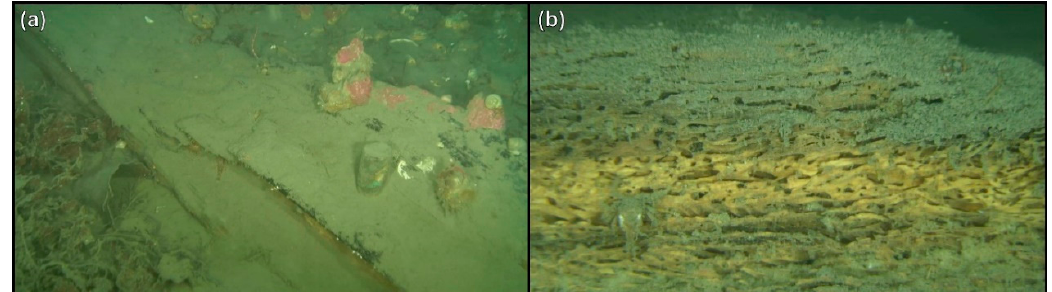
Figure 3. Autonomous underwater vehicle (AUV)-acquired sidescan sonar (SSS) images from alternate sides of the Figaro in Trygghamna. Panels ( a ) and ( b ) respectively show images from the starboard-side and port-side AUV passes of the wreck. The wreck measures approximately 50 m long, and 11 m wide.